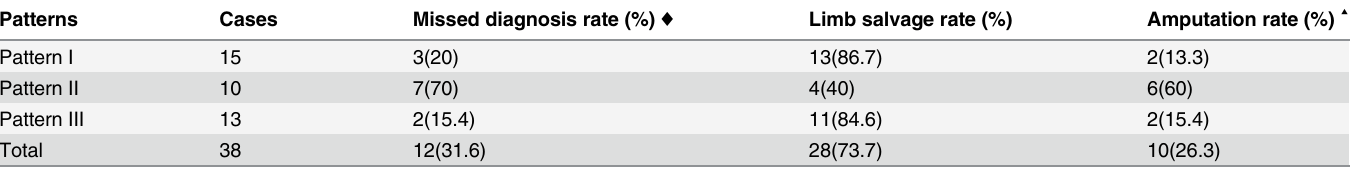
Table 2. Missed diagnosis rates and amputation rates of different patterns.